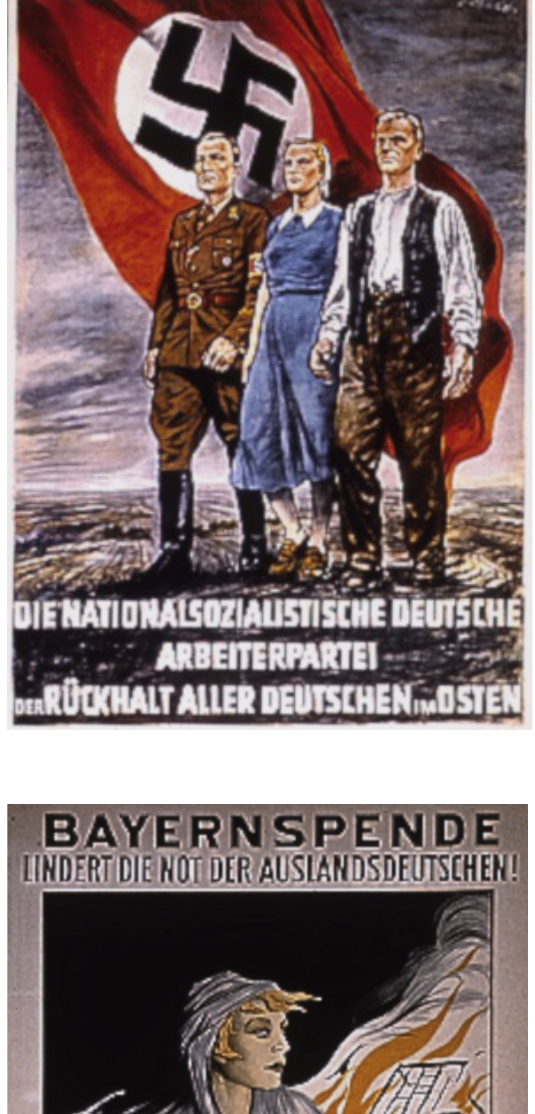
"Bavarian charity drive: ease the need of Germans living outside Germany! Help the pioneers of the German way of life!," 1939-45. Poster Collection, Hoover Institution Archives, GE